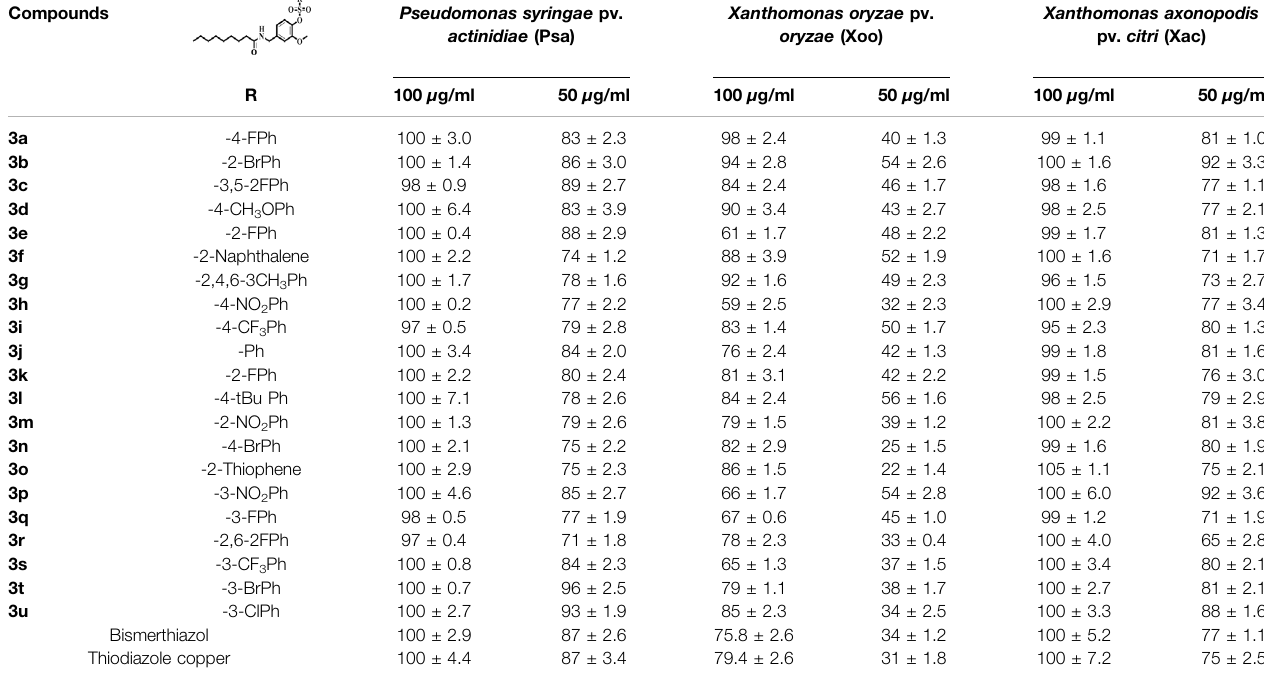
TABLE 1 | The in vitro antibacterial activities of the target compounds 3a – 3u . Compounds